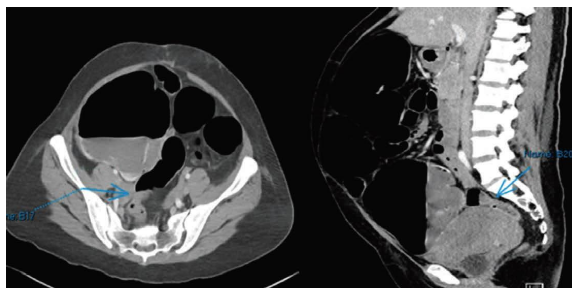
Figure 2: Whole abdominal CT scan with contrast. Description: large bowel obstruction with transition point at the rectosigmoid junction, likely from postoperative adhesions; pneumatosis coli in the cecum and ascending colon; no ascites, pneumoperitoneum, or enlarged lymph nodes; prominent-sized appendix without in- fammatory changes; and anteverted and globularly enlarged uterus with a prominent